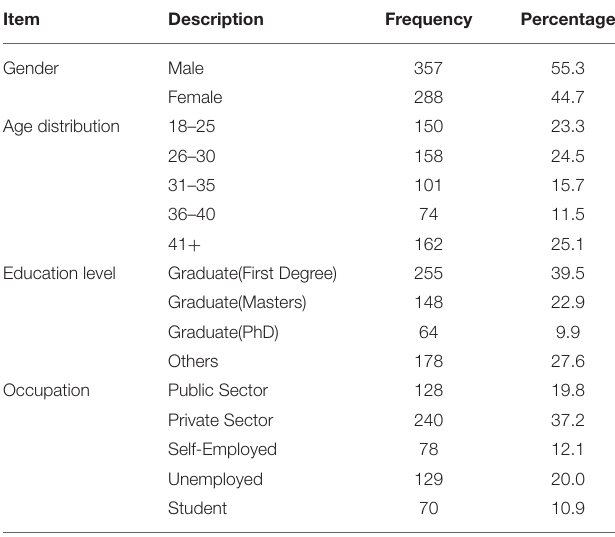
TABLE 4 | Demographic profile of